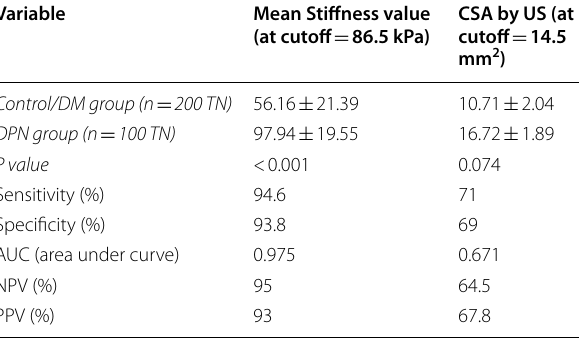
CSA cross sectional area, DM Diabetes mellitus, DPN Diabetic peripheral − neuropathy, kPa kilopascals, NPV Negative predictive value, PPV positive predictive value, TN Tibial nerve